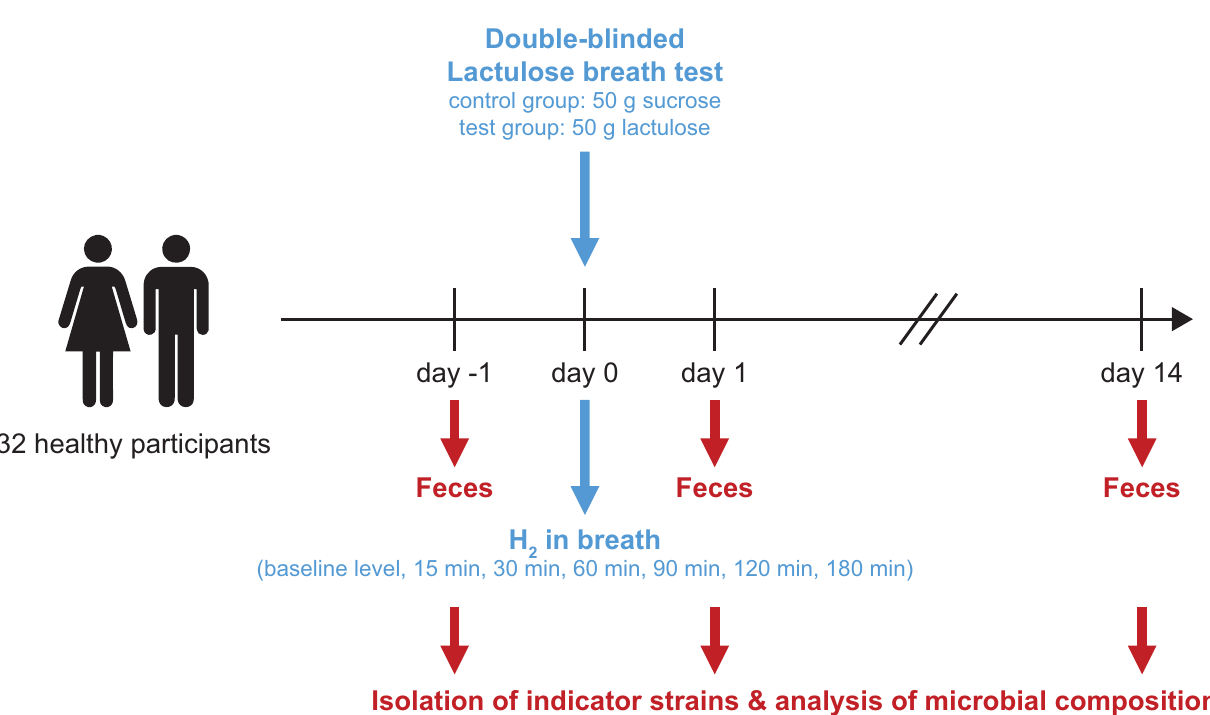
Fig 2. Overview of the design of our study. 32 healthy participants were randomly assigned to either the control group (sucrose) or to the experimental group (lactulose). Fecal samples were collected one day before treatment, one day after treatment and two weeks after treatment for further microbial analysis. On the day of treatment, hydrogen levels were measured in expiratory air at the indicated time points.